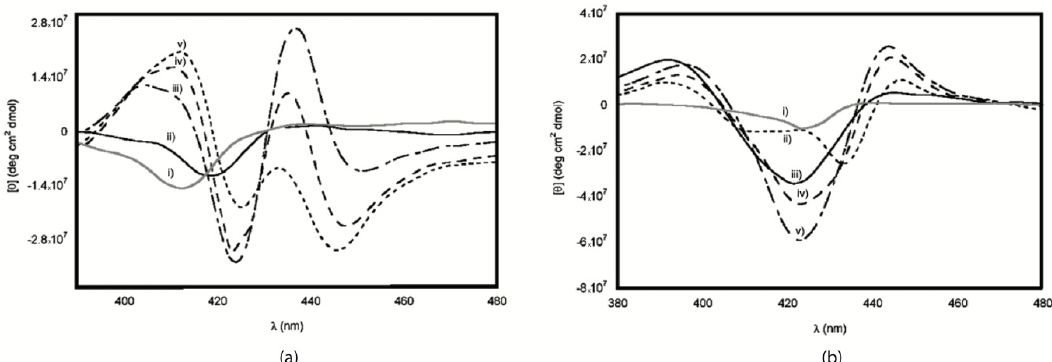
Figure 8. CD spectra of glucosylated steroid-porphyrins 12 ( a ) and 13 ( b ) (5 μ M) in DMSO/H 2 O at increasing water content: a. 0%; b.20%; c. 30%; d. 40%; e. 50% Adapted with permission from [37]. Copyright 2012, Royal Society of Chemistry.